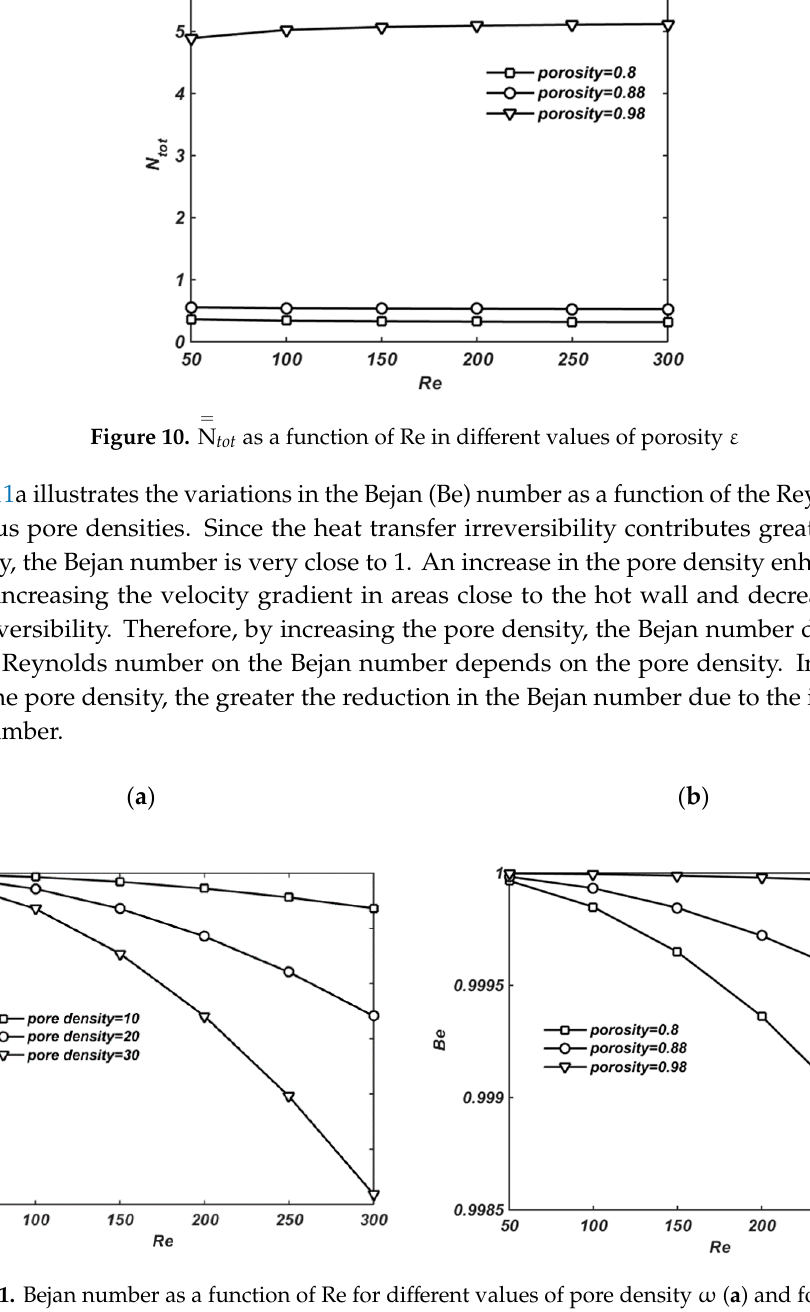
Figure 9. N(cid:3368) (cid:3047)(cid:3042)(cid:3047) as a function of the Reynolds number (Re) in different ω .